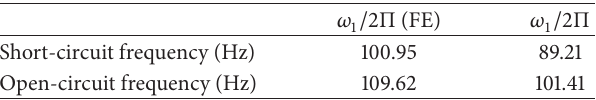
𝜔 /2Π (FE) 𝜔 /2Π 1 1